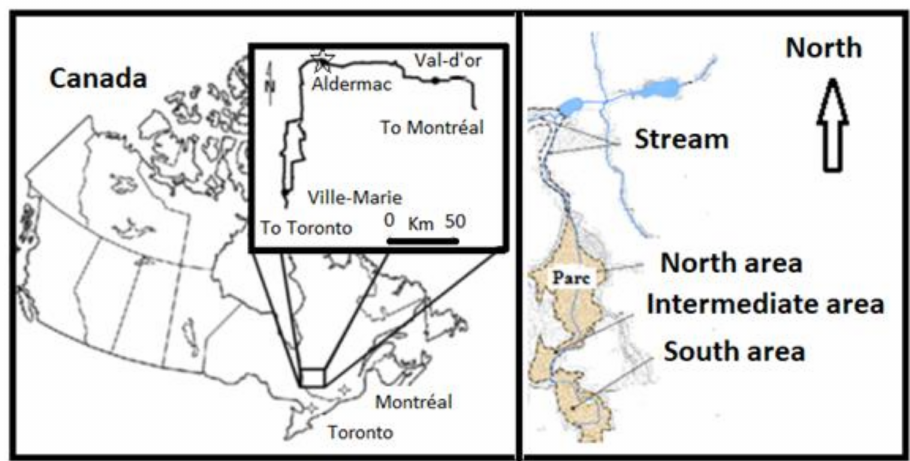
Figure 1. Location of the Aldermac mine site (modified from